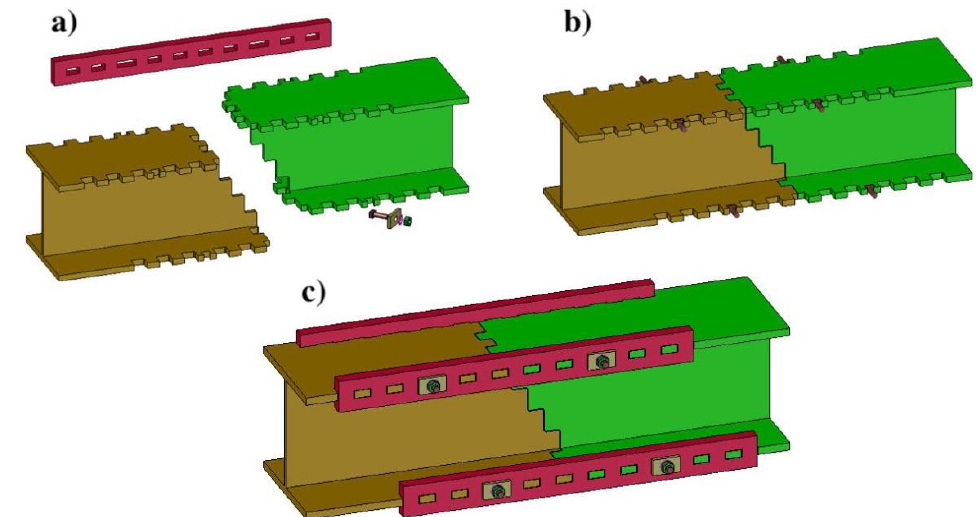
Figure 4. Side ISC: ( a ) components of the side ISC connection; ( b ) assembled components with side bolts in place; ( c ) the completed side ISC connection.